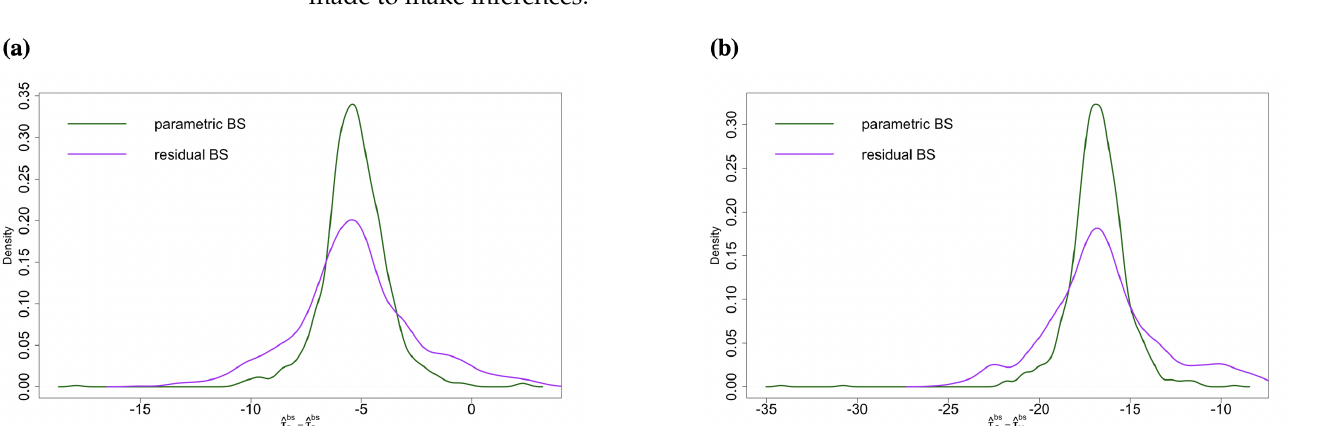
− ˆ τ bs , which is significant in the parametric bootstrap case B D − ˆ τ bs , which is significant in both H G